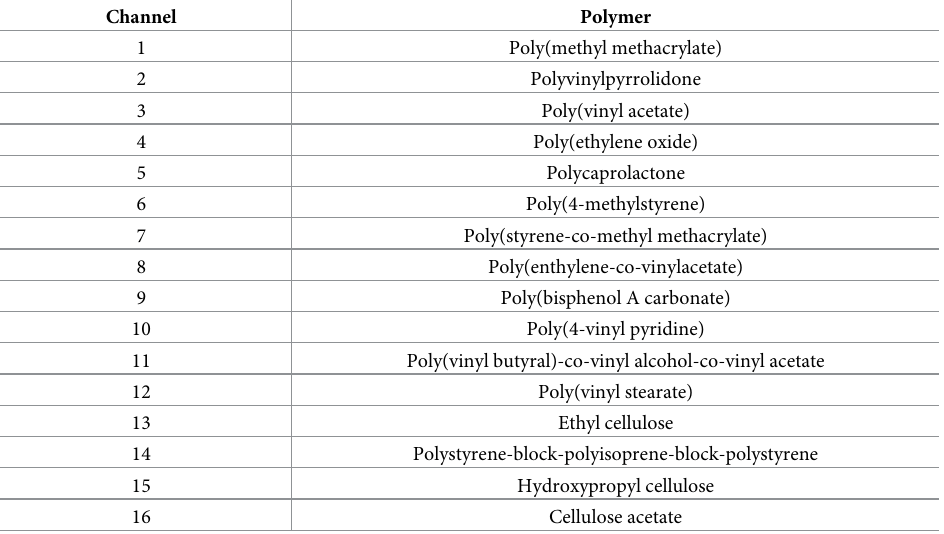
Table 1. CB polymer composites in the sensor